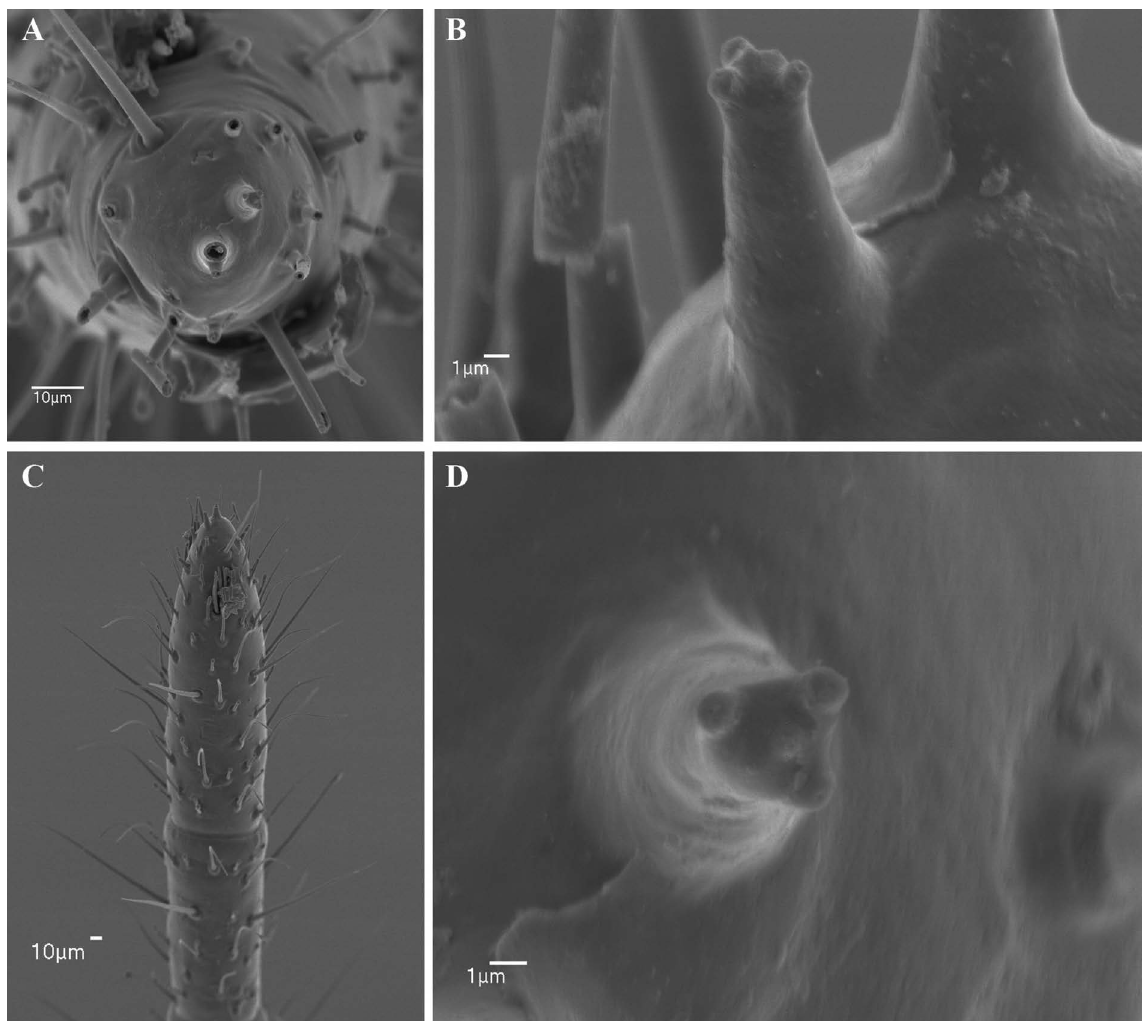
Fig. 140. Sarax bispinosus (Nair, 1934) (AMNH), antenniform leg I, ♂ . A . Apex of distal article of tarsus. B . Tarsal organ near tarsal claw, lateral view. C . Distal article of tarsus showing rod sensilla. D . Tarsal organ near tarsal claw, frontal